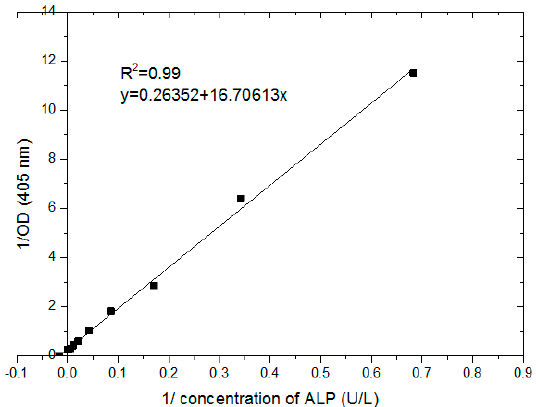
Figure 8. The standard curve of the absorbance values vs. alkaline phosphatase (ALP) concentration ranging from 1.5–1500 U / L was fitted by the Lineweaver–Burk model with R 2 = 0.99. Table 3. Summary of ALP release from each cell line versus target days at post-confluence culture. Quantity of ALP Release (U / L) in Each